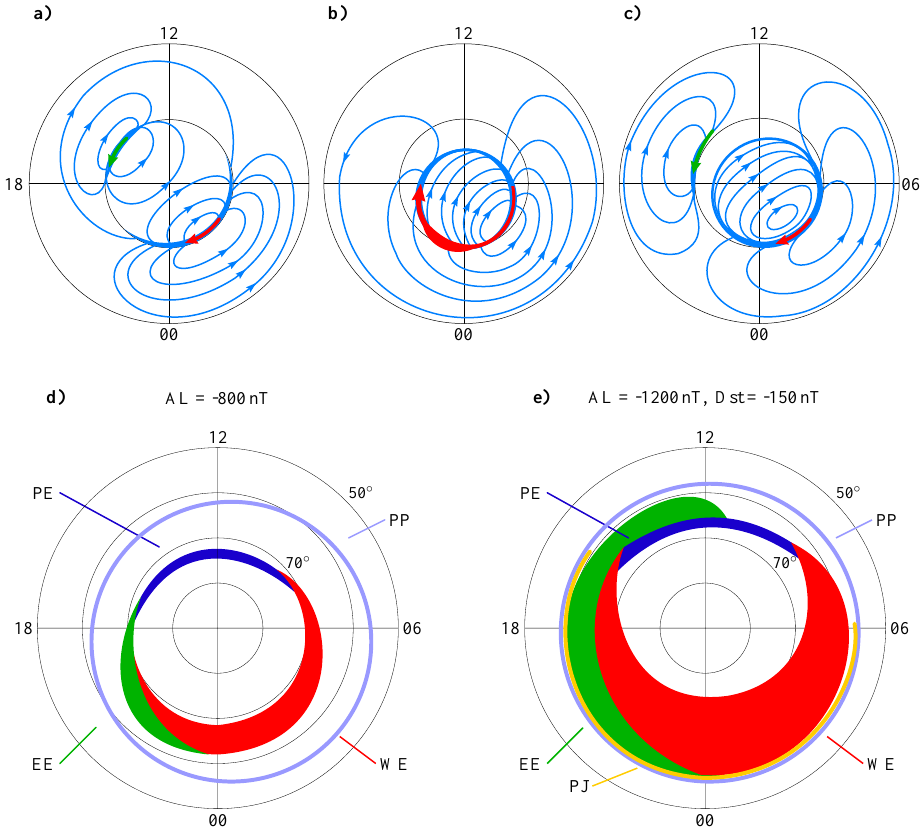
Fig. 15. Schematic view of the electrojets space-time distribution at ionospheric altitudes: (a) classical current system according to Fukushima (1953); (b) single-vortex system with westward electrojet along the AO according to Akasofu et al. (1965); (c) double-vortex system with westward electrojet along the auroral oval and eastward electrojet in the evening sector at the latitude of the auroral zone ac- cording to Feldstein and Zaitsev (1965); (d, e) substorm and strom conditions are considered separately: the magnetospheric substorm with AL ∼− 800nT (d) and the magnetic storm main phase with AL ∼− 1200nT, D st ∼ 150nT